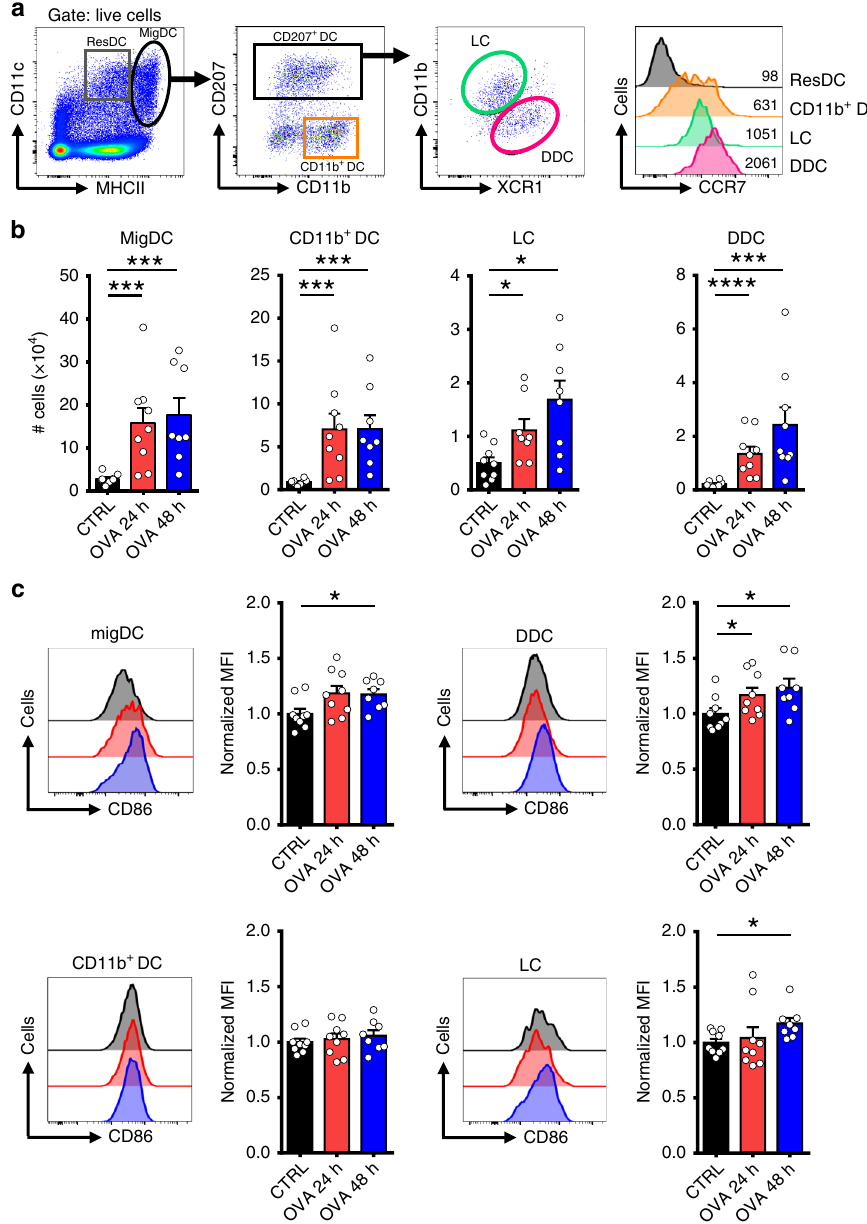
Fig. 2 Trm cell activation promotes migration of dermal DCs. C57BL/6 mice bearing OVA-speci fi c skin Trm cells and depleted of circulating CD8 + T cells by administration of an anti-CD8 antibody were intradermally inoculated with control (CTRL) or OVA (257-264) peptides followed by analysis of inguinal draining lymph nodes after 24 h (OVA 24 h) and 48 h (OVA 48 h). a Gating strategy used to identify the different DC subsets in skin draining lymph nodes, including: lymph node-resident DCs (ResDC), migratory DCs (MigDC), CD11b + DCs, LCs and DDCs. Representative histograms showing CCR7 expression on relevant subpopulations. b Quanti fi cation of total numbers of the different DC subsets. c Representative histograms (black: CTRL; red: OVA 24 h; blue: OVA 48 h) and graphs showing CD86 expression of each DC population. For quanti fi cation, the geometric mean fl uorescence intensity (MFI) was normalized relative to the average of the control group. Pooled data from two independent experiments n = 9 mice per group. Bars are the mean ± SEM. * p < 0.05, **p < 0.01, *** p < 0.01 by Mann-Whitney unpaired